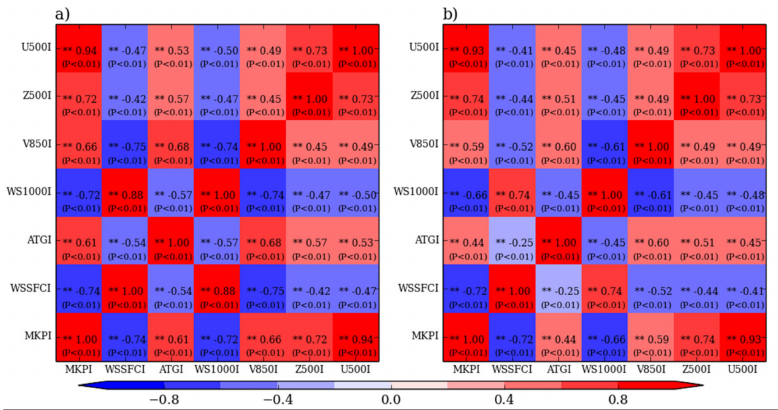
Figure 4. Correlation matrix between the individual indices (MKPI, WSSFCI, ATGI, WS1000I, V850I, Z500I, and U500I) on ERA-Interim ( a ) and CMIP6 ( b ) during the winters of the 2001–2014 period. ** indicates statistical significance at the 99% confidence